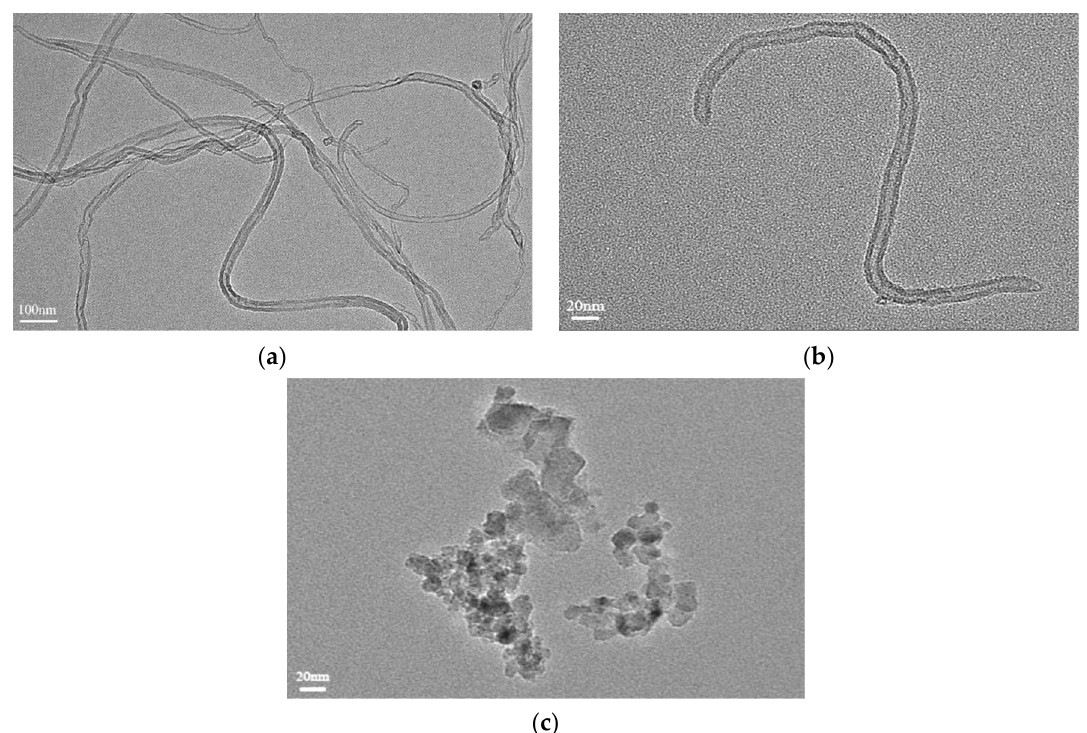
Figure 2. Transmission electron microscopy (TEM) images of different samples; ( a ) MWCNTs (100 nm); ( b ) acid-treated MWCNTs (20 nm); ( c ) MWCNTs/Cu-Cr-TiO 2 (Cu/Cr = 3, 20 nm).